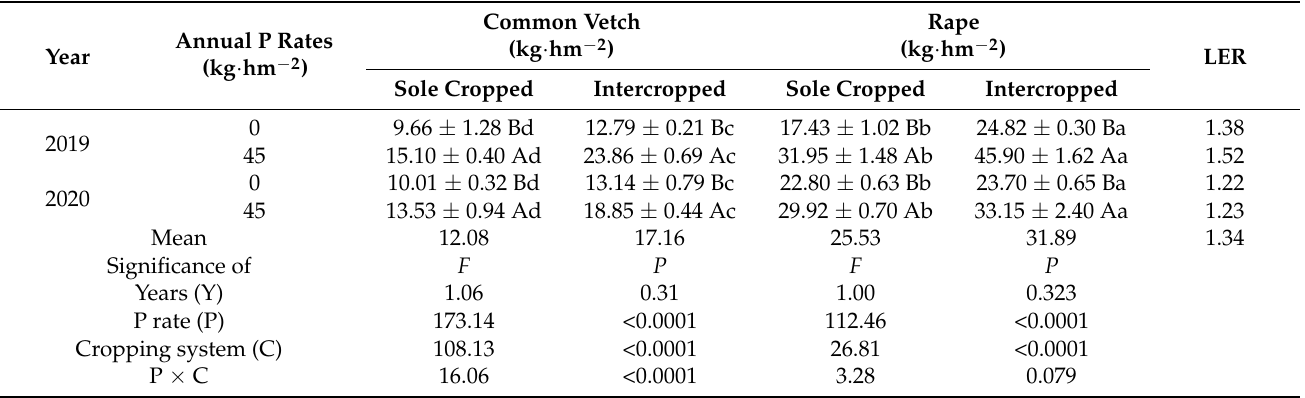
Table 2. Dry matter yield ( × 10 3 kg · hm − 2 ) of common vetch and rape and land equivalent ratios (LER) as affected by phosphorus (P)-fertilization rate and cropping system from 2019 to